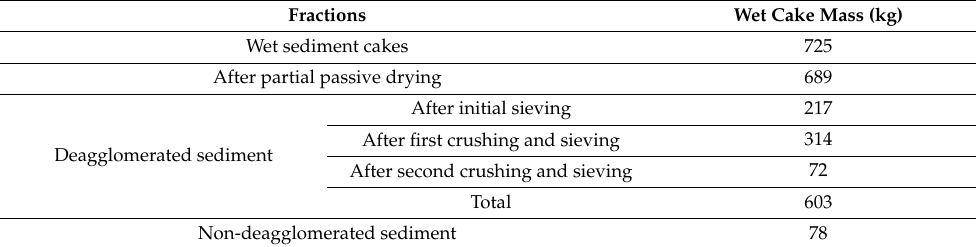
Table 7. Mass balance of the ALS sediment deagglomeration process.